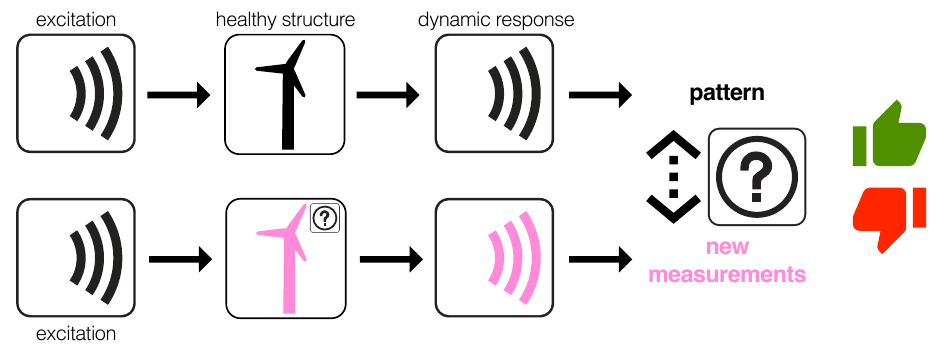
Figure 2. Guided waves in structures for structural health monitoring. The healthy structure is excited by a signal and the dynamic response is measured to create a baseline pattern. Then, the structure to diagnose is excited by the same signal and the dynamic response is also measured and compared with the baseline pattern. A significant difference in the pattern would imply the existence of a fault.